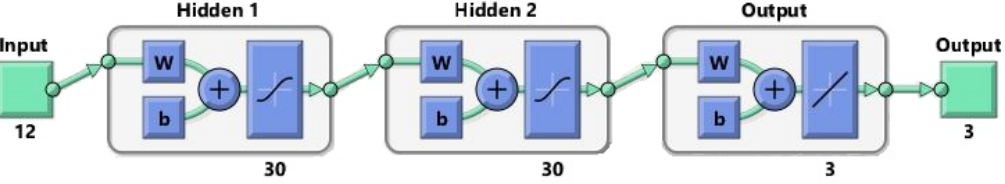
Figure 5. Neural Network